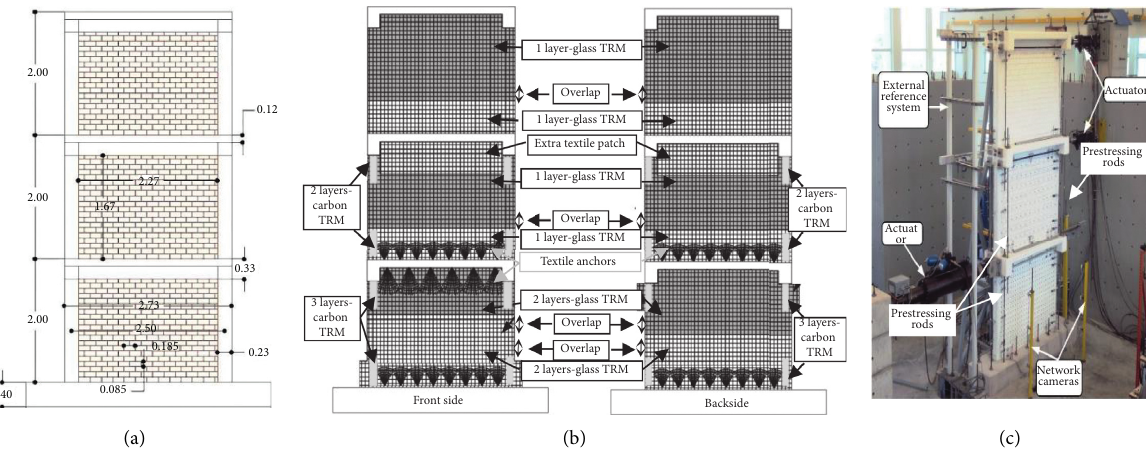
Figure 1: (a) Geometry of the masonry-infilled RC frame and (b) the strengthening scheme: textile anchors of the first and the second storeys and the TRM layer on the faces of masonry infill at the first, second, and third storeys. (c) Test setup.